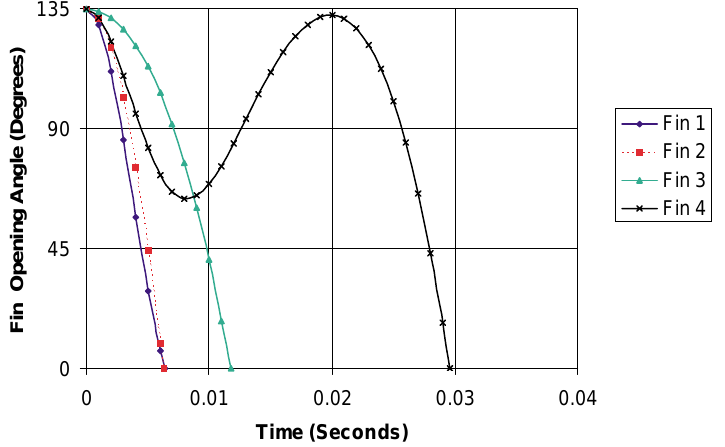
Fig. 12. Fin opening angle as a function of time, five degrees of yaw, 15.6 Hz spin